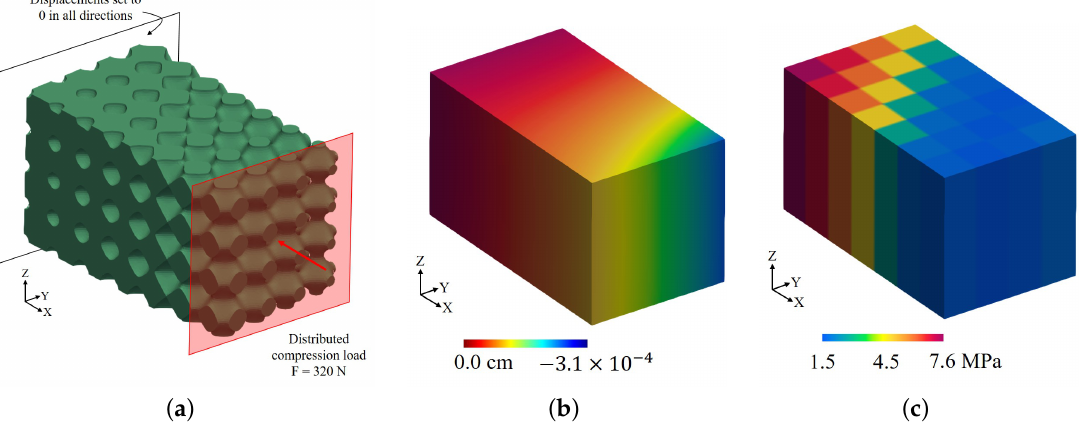
Figure 11. Application of our methodology to a large Schwarz primitive domain of 112 cells of density per Equation (12). ( a ) Domain and boundary conditions; ( b ) displacement in X direction in the homogeneous domain; and ( c ) maximum von Mises stress per cell in the homogeneous